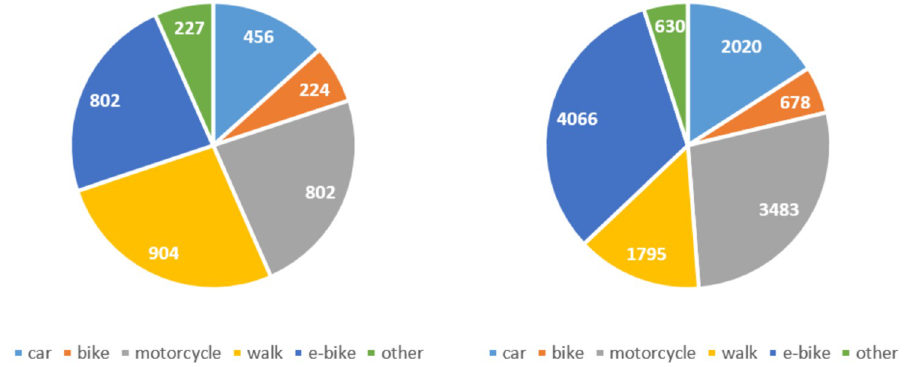
Fig 1. Statistics of traffic accidents in 36 major cities in mainland China in 2019. (a) The number of fatalities. (b) The number of injuries.